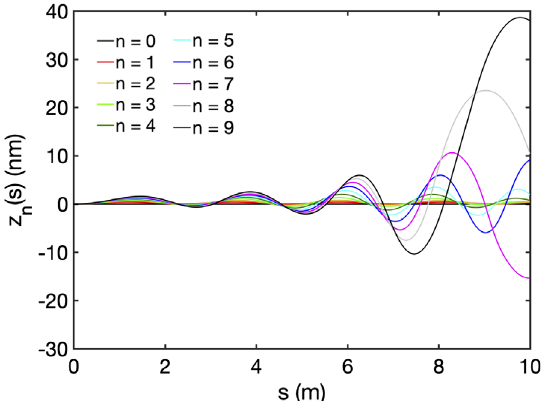
FIG. 6. Evolution of the longitudinal centroid offsets along s based on Eq. (17). Here, we assume the initial offsets ˆ z n ð 0 Þ ¼ 0 for all ten microbunches ð n ¼ 0 (cid:6) 9 Þ